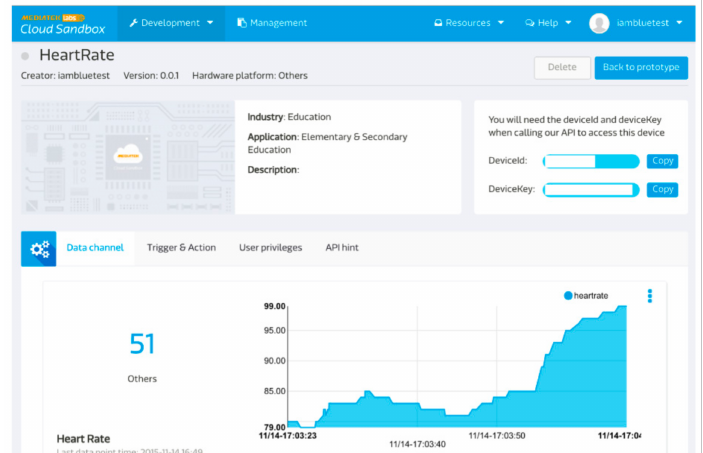
Figure 6. MCS system interface.